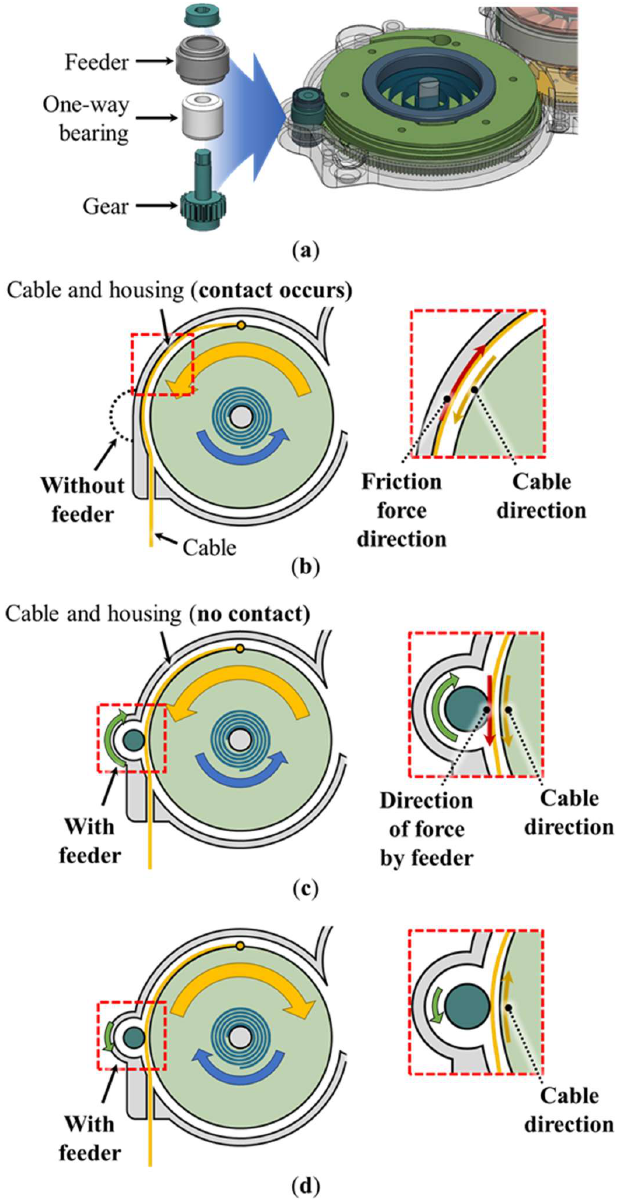
Figure 6. Feeder mechanism design: ( a ) components of the feeder mechanism; ( b ) pulley without the feeder (the frictional force acts in the direction opposite to the cable-release direction); ( c ) pulley with the feeder (the force associated with the feeder acts in the same direction as the cable-release direction); ( d ) pulley with the feeder (free rotation in the cable-winding direction). To verify the effect of the feeder, the friction of the model with and without the feeder was compared. As shown in Figure 7a, the pulley part of the dual pulley drive, combined with the spool, was fixed on the surface plate. The wire of the spool was connected to the motor system through a load cell (LSB205, Futek, MI, USA). When the EC 4-pole 30 brush- less motor (#305013, Maxon, Switzerland) with the planetary gearhead (#326664, Maxon, Switzerland) pulled the wire (with the wire wound in the spool and the cable wound in the pulley), the cable released as the pulley rotated. The friction between the cable and housing was measured using a load cell. The wire was pulled at a low velocity of 5 mm/s to eliminate the inertia of the pulley. The motor position and velocity were controlled us- ing a system engineering software (LabView 2019, National Instruments, Austin, TX,